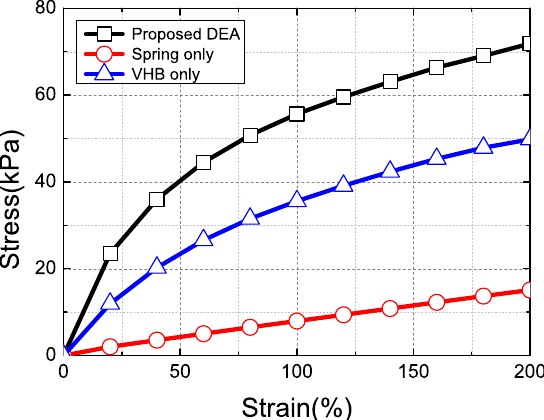
Figure 7. Measured stress-strain characteristics of entire device, individual copper springs, and VHB film, respectively.